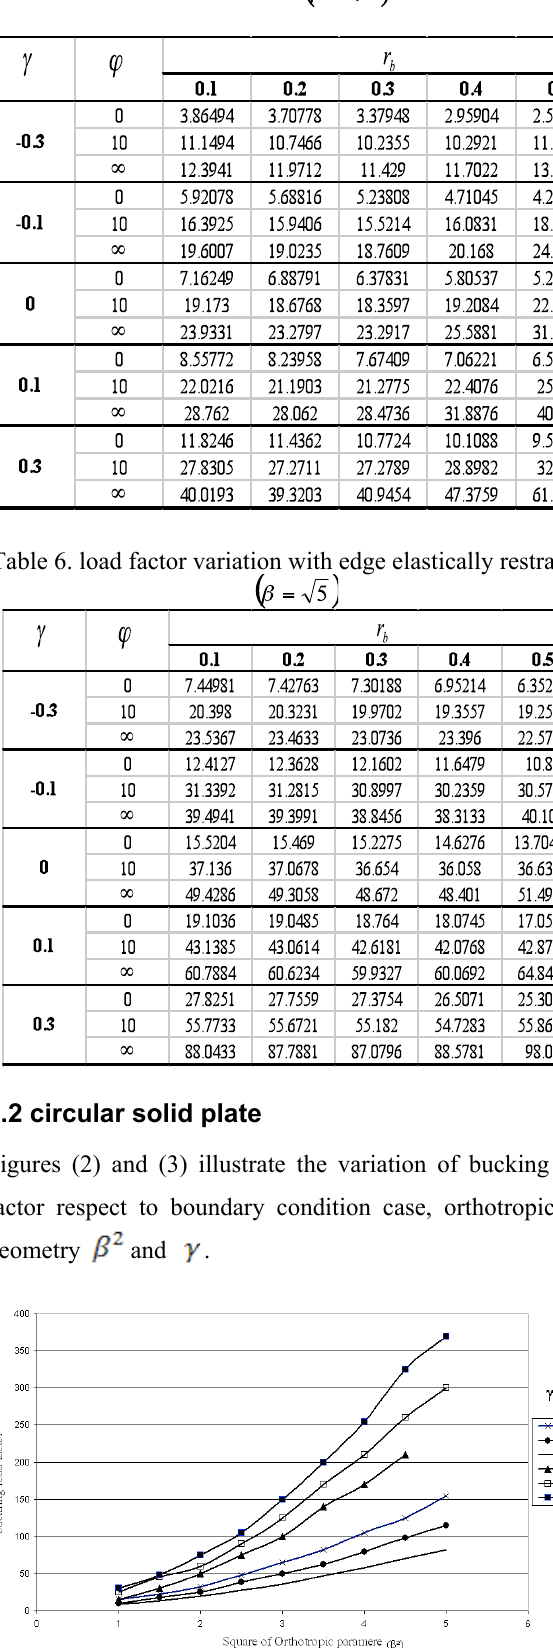
Table 5. load factor variation with edge elastically restrained